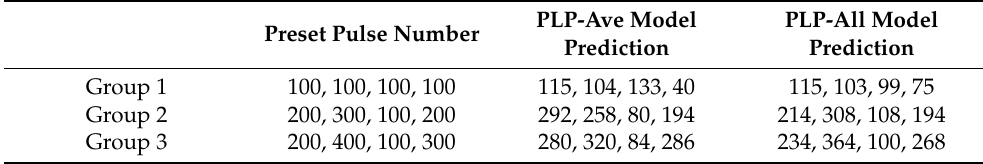
Table 2. The predicted results of mixed